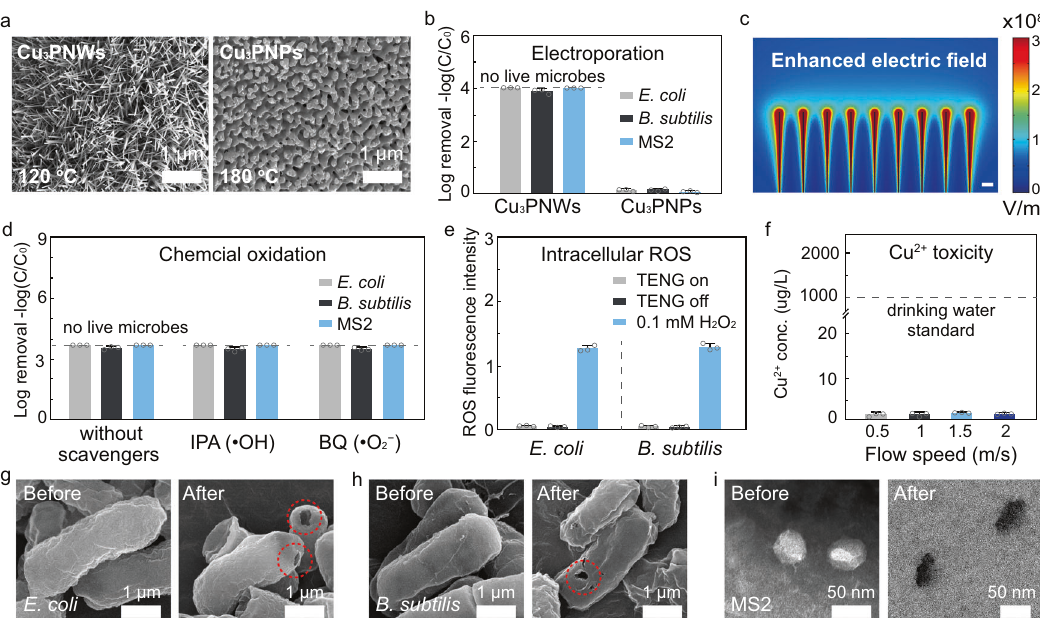
Fig. 5 Disinfection mechanism investigation into the nanowire-modi fi ed positive electrode. a SEM images showing the Cu(OH) 2 NW-Cu electrode after the phosphidation process at 120 and 180 °C forming the Cu 3 P with the geometry of nanowire (left) and nanoparticle (right), respectively. b Disinfection performance of the RV-disinfection system using nanowire- and nanoparticle-modi fi ed electrodes, showing the enhanced performance of the nanowire structure. Dashed lines indicate that no live microbes can be detected. c Simulation of electric fi eld distribution near the surface of Cu 3 PNW (diameter, 50 nm; length, 5 μ m) driven by the V-TENG, showing the enhancement of the localized electric fi eld. The scale bar is 500 nm. d – f Investigation of other mechanisms that may contribute to RV-disinfection. d Disinfection performance of RV-disinfection system with or without the added scavengers (isopropanol; IPA and benzoquinone; BQ). Dashed lines indicate that no live microbes can be detected. The radical scavengers can react quickly with speci fi c oxidizing agents (IPA for ·OH and BQ for ·O 2 − ) to eliminate the chemical oxidation. e Measurement of the intracellular reactive oxygen species (ROS) caused by the physiological change transfer. In ( d ) and ( e ), the air fl ow rate was fi xed at 2 m/s. f Concentrations of copper ions (Cu 2 + ) after 0.5 m 3 of air fl ow collected in 500 mL of water, showing no contribution of Cu 2 + to RV-disinfection. Dashed lines indicate the Cu 2 + concentration standard for safe drinking water (1000 µ g/L). g – i SEM images of bacteria and transmission electron microscope (TEM) images of viruses before and after fl owing through the RV-disinfection system, showing the disinfection mechanism of electroporation. SEM images of E. coli (Gram-negative bacteria ( g )) and B. subtilis (Gram-positive bacteria ( h )) before (left) and after (right) RV-disinfection operation. After operation, electroporated pores were found generated on the bacterial membranes. i TEM images of viruses (MS2) before (left) and after (right) RV-disinfection operation. After operation, the MS2 capsid was damaged and the inside was stained. In ( g – i ), the air fl ow rate was fi xed at 2 m/s. The V-TENG was operated at a constant amplitude (500 μ m) and vibration frequency (30 Hz). The error bars represent the standard deviation of three replicate